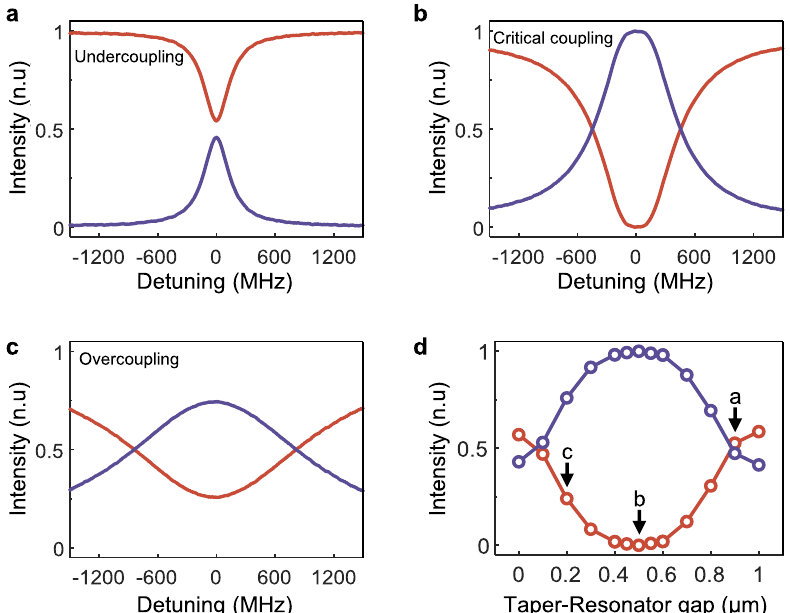
Fig. 3 Perfect absorption on an exceptional surface with fully re fl ective end-mirror. Absorption spectra A cw (purple curves) are inferred from the measured re fl ection spectra R cw (red curves) using A cw þ R cw ¼ 1 for a CW input and fully re fl ective fi ber loop ( r j j ¼ 1). Spectra measured at ( a ), undercoupling regime, ( b ), critical coupling, and ( c ), overcoupling regime reveal perfect absorption on the ES with a quartic absorption lineshape only for critical coupling, as in ( b ). As the system moves away from the critical coupling regime the quartic behavior becomes indiscernible. d Measured re fl ection and calculated absorption exactly at the ES frequency (i.e., zero detuning) for various taper-resonator coupling strength γ the taper and the resonator show the highest absorption at the critical coupling (i.e., gap equals to (cid:7) 0 : 5 μ m) where we have R cw ¼ 0 and thus A cw ¼ 1. As the system moves from critical coupling toward undercoupling or overcoupling regimes, absorption at the resonance monotonously decreases. Circles are the values extracted from experimental data and the straight lines are inserted as guides to the eye. The labelled points in ( d ) are obtained from the spectra shown in ( a , b , and c ). For a CCW input, all the light is back-re fl ected by the mirror and no light reaches the resonator, therefore absorption is zero, A ¼ 0, and hence chiral absorption on the ES. ccw